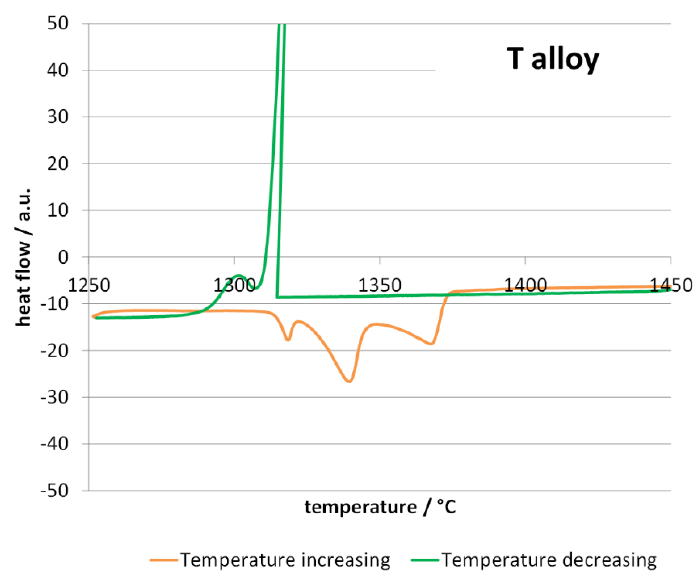
Figure 2. Differential thermal analysis (DTA) curve obtained for the T alloy.